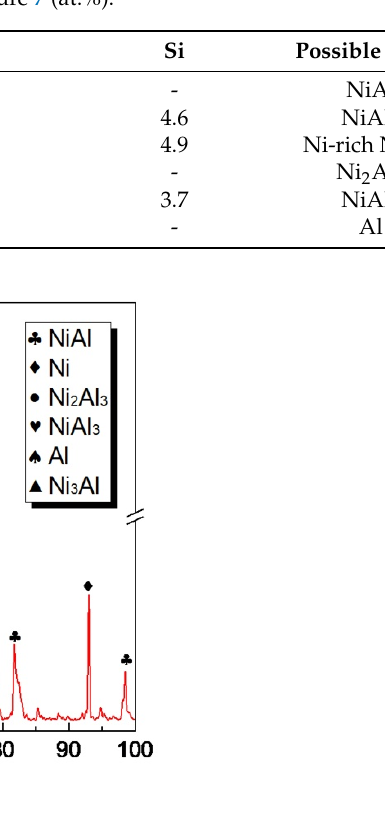
Figure 9. Microstructure of joint bonded with Al/Ni/Zr interlayer (10 wt.% Zr). ( a ) Overall joint; ( b ) interface on right side; ( c ) interface on left side; ( d ) joint center.